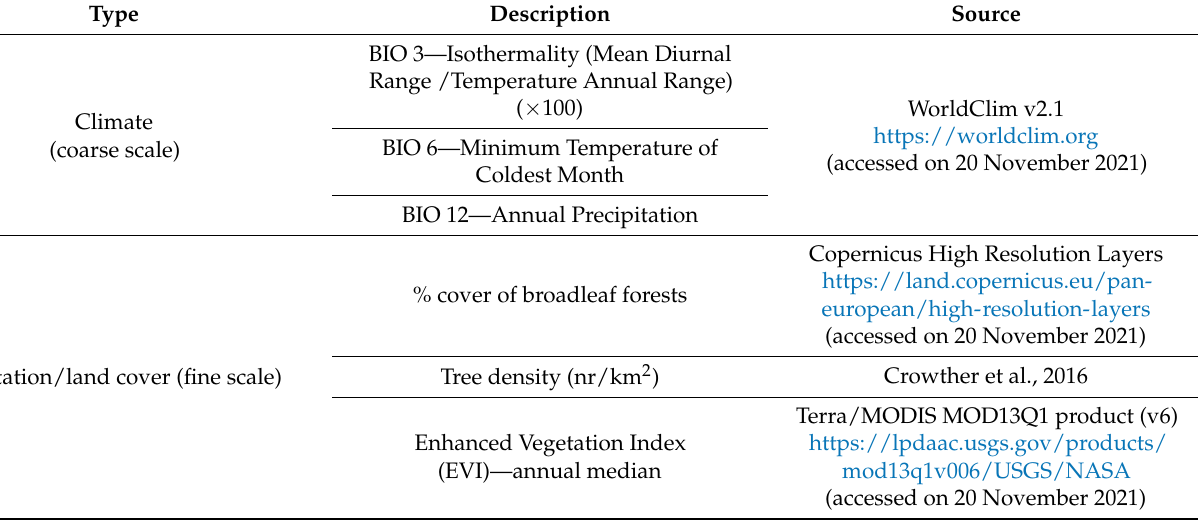
Table 2. Selected variables used for developing habitat suitability models and respective data sources. Type